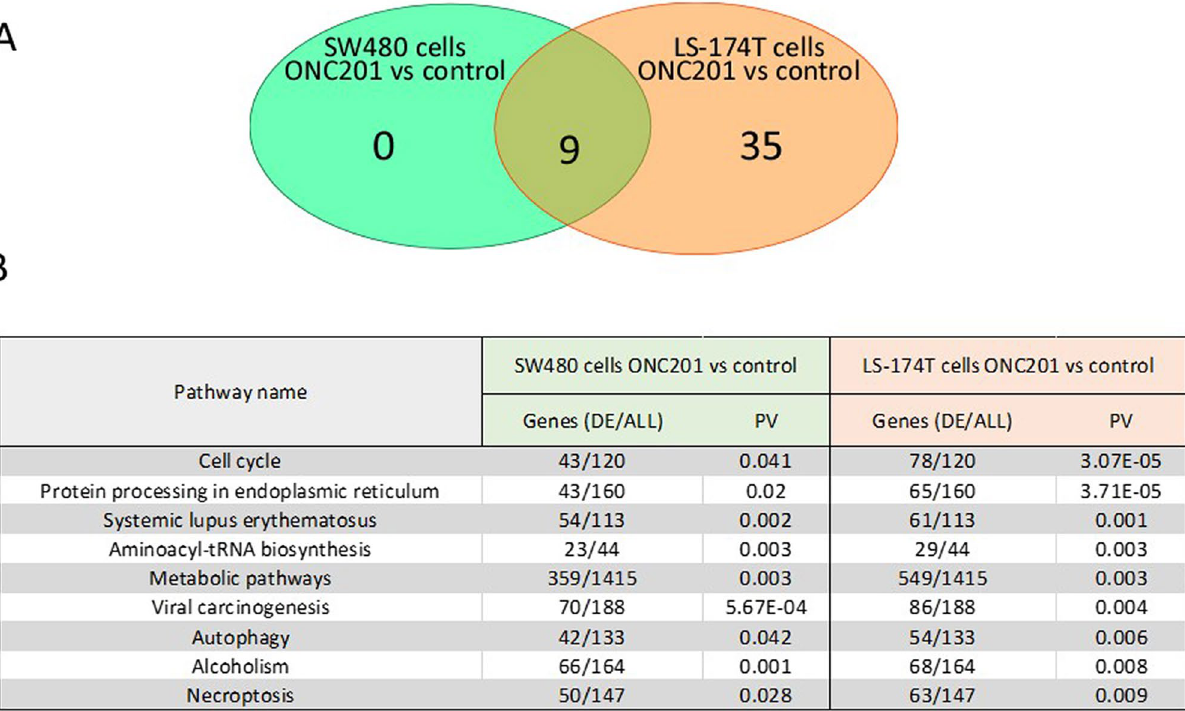
Figure 3. Meta-analysis alignment of differentially expressed common pathways in response to ONC201 treatment. ( A ) Venn diagram illustrating the number of signaling pathways differentially perturbed in response to ONC201 treatment in nonmetastatic and metastatic cell lines. The overlapping area indicates the number of signaling pathways commonly altered in both cell types. ( B ) Nine common pathways modified in both cell types in response to ONC201 treatment and the number of altered genes per